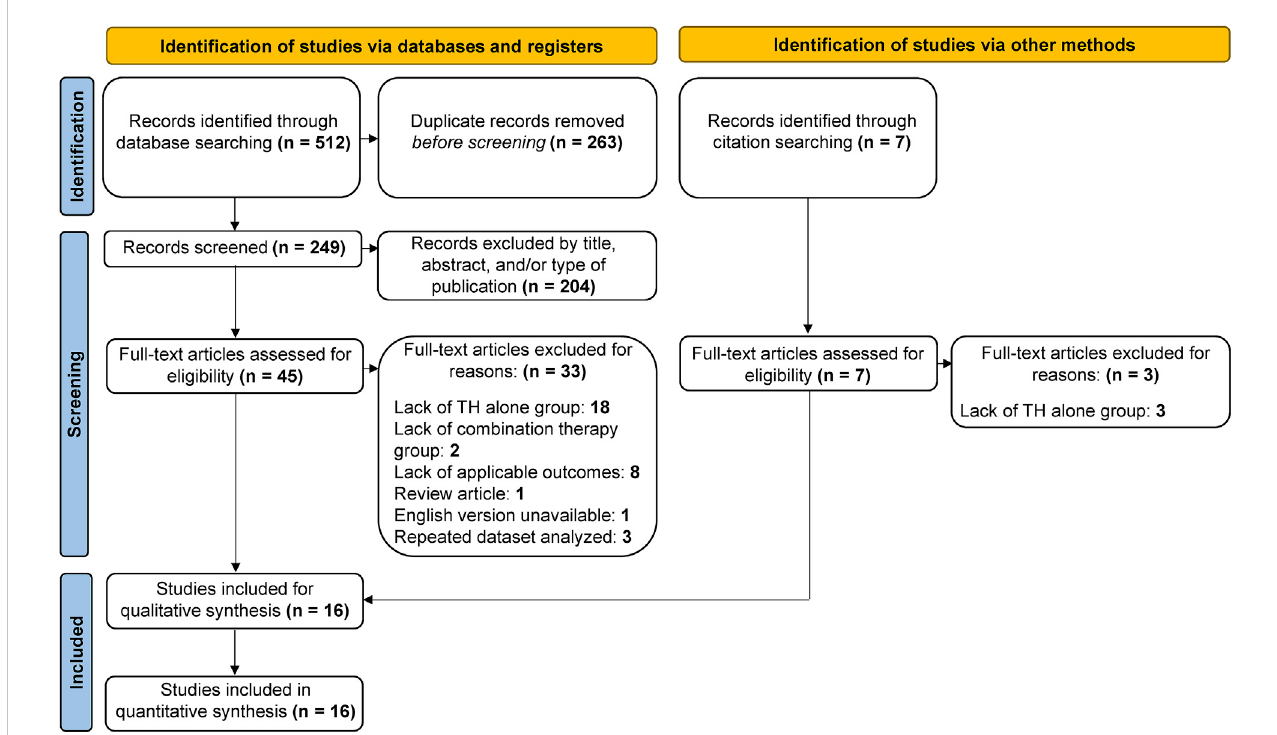
Flow diagram of study screening process. The search strategy resulted in 519 articles, 263 of which were duplicates, leaving 256 for screening. Of these, 204 were deemed irrelevant, leaving 52 articles for full-text review. A total of 16 studies met the predetermined inclusion criteria and were included in the present